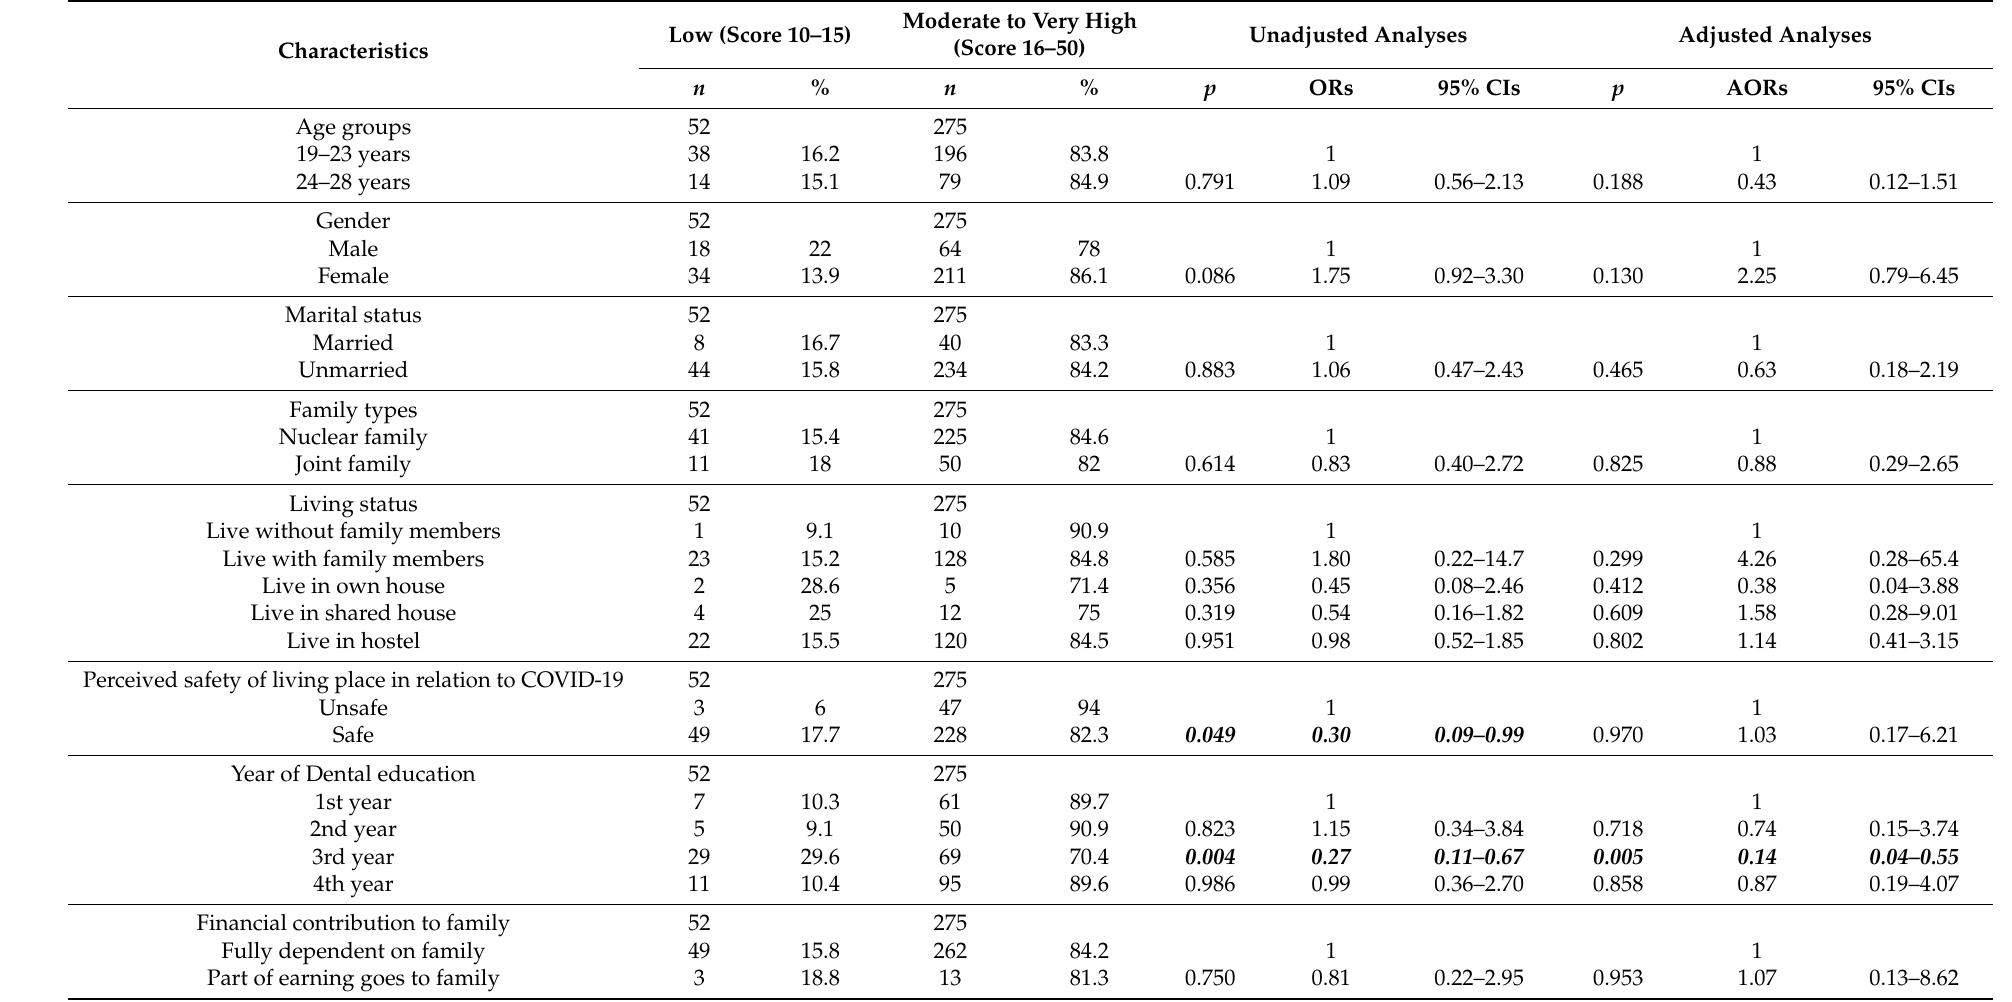
Table 5. Predictors for high psychological distress among the study population (based on K10